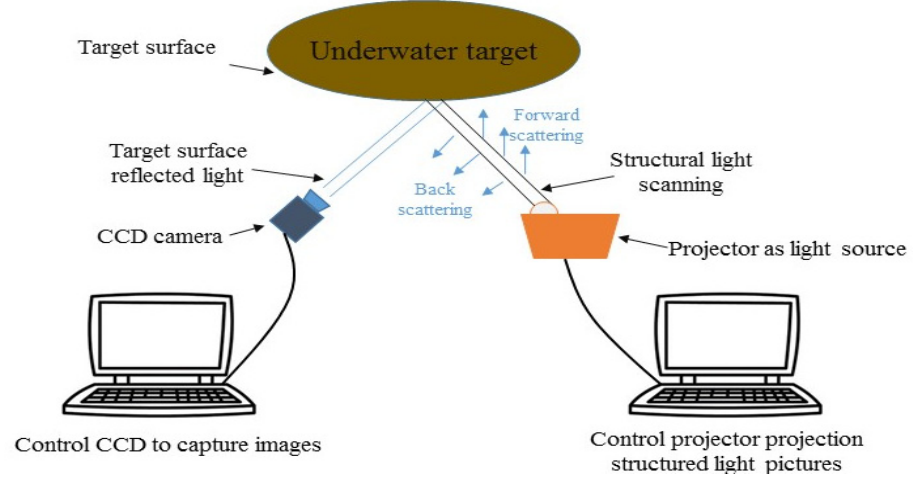
Figure 2. System implementation.